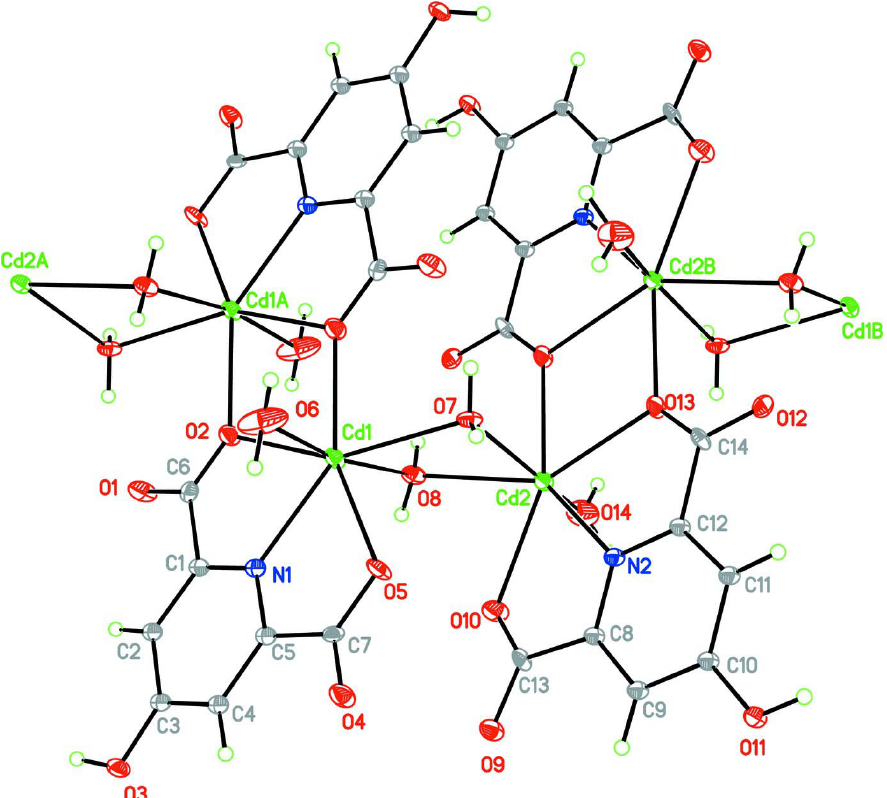
The molecular structure of the title compound as a fragment of the polymeric chain. Displacement ellipsoids are drawn at 50% probability level. Symmetry codes to generate atoms with labels: A: - x + 1,- y + 1,- z + 1; B: - x + 1, - y , - z +